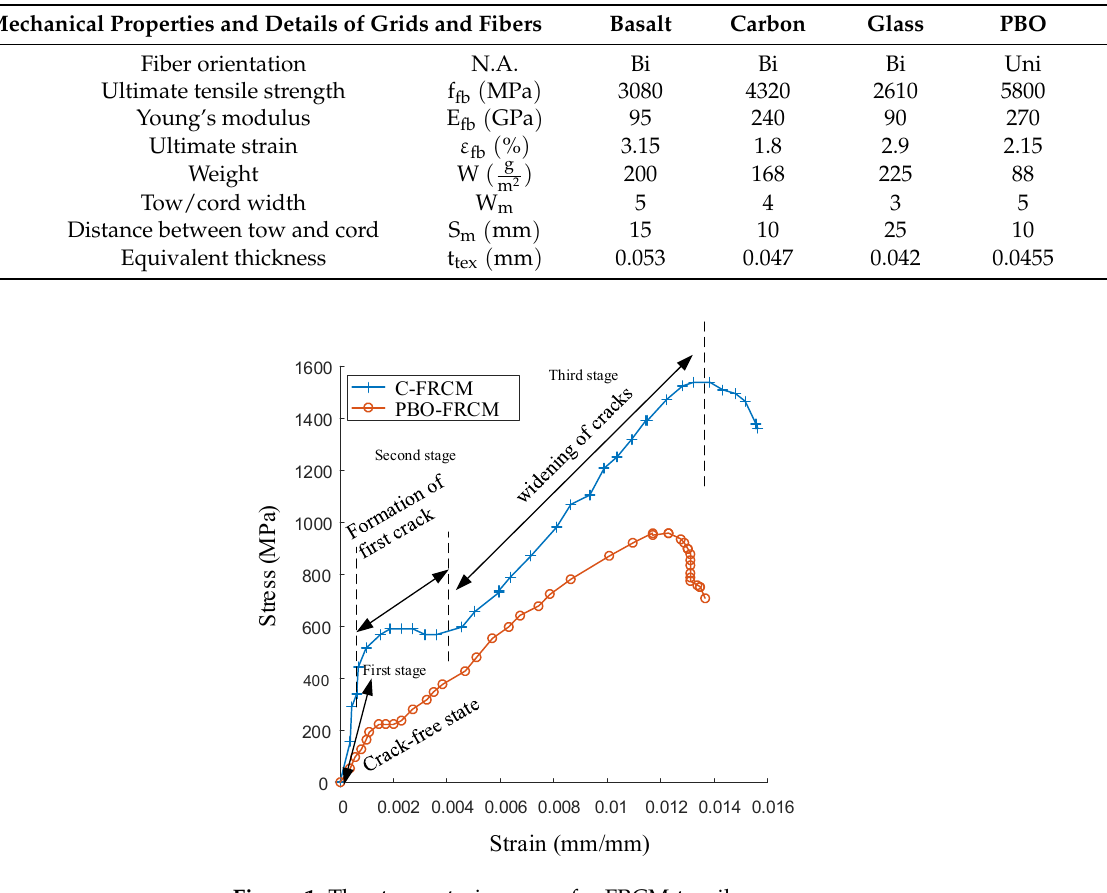
Table 2. The properties of grids and fibers.